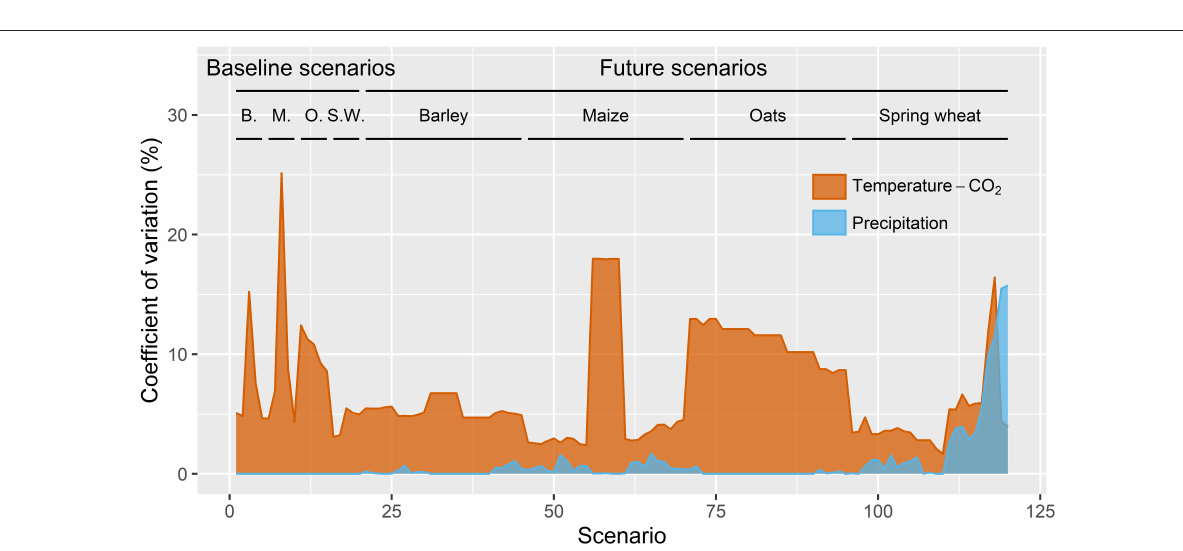
FIGURE 4 | Comparison of temperature-CO 2 vs. precipitation related coefficients of variation of simulated yields. The coefficient of variation is computed over the 26 years of simulation of a given scenario for the same site and crop and regrouped according to the increase in temperature and CO 2 (to assess the effects of precipitation) or changes in precipitation (to assess the effects of temperature and CO 2 ). B., M., O. and S. W. stand for barley, maize, oats, and spring wheat,